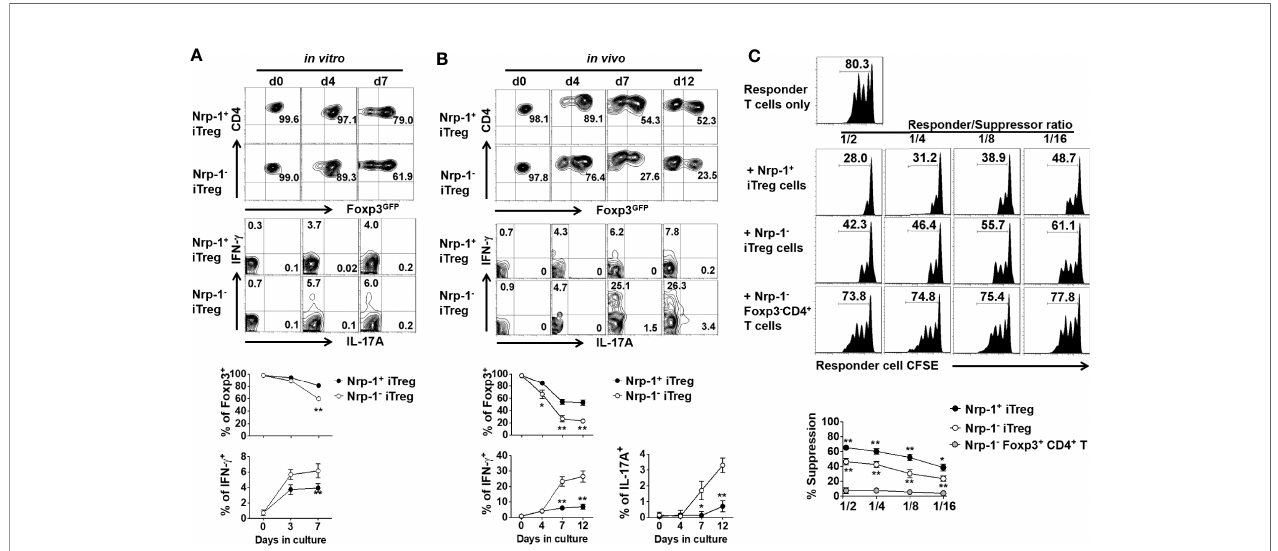
FIGURE 2 | Foxp3-GFP + Nrp-1 + iTreg was more stable in vitro and in vivo with a prior suppression in vitro . (A) Foxp3-GFP + Nrp-1 + iTreg and Foxp3-GFP + Nrp-1 - iTreg were sorted from iTreg, and then cultured with CD3CD28 beads (cells/beads 1/5)+rhIL-2 (10ng/ml) for several days in vitro . Cells were harvested at indicated days; Foxp3-GFP, IFN- g , and IL-17a were measured on GFP + Nrp-1 + iTreg and GFP + Nrp-1 - iTreg by FACS. Representative FACS plots and the summarized data of three separated experiments were shown. (B) GFP + Nrp-1 + iTreg and GFP + Nrp-1 - iTreg were transferred into Rag1 -/- mice. Mice were sacri fi ced, spleen cells were harvested at indicated days; Foxp3-GFP, IFN- g , and IL-17a were measured on GFP + Nrp-1 + iTreg and GFP + Nrp-1 - iTreg by FACS. Representative FACS plots and the summarized data of three separated experiments were shown. The data indicated Mean ± SEM of two separate experiments (n=6) (* p <0.05, ** p <0.01). (C) Freshly isolated T cells (responder cells) labeled with CFSE were stimulated with anti-CD3 mAb (0.025 m g/mL) and irradiated APCs (30 Gy, 1:1 ratio) for 3 days, with or without Foxp3GFP + Nrp-1 + iTreg or Foxp3GFP + Nrp-1 - iTreg or Foxp3GFP - Nrp-1 - CD4 + T cells. (The ratio of Treg: T cells was 1:2-1:16) T-cell proliferation was determined by the CFSE dilution rate after 3 days of culture. The data indicate the Mean ± SEM of 3 separated experiments (* p <0.05, ** p